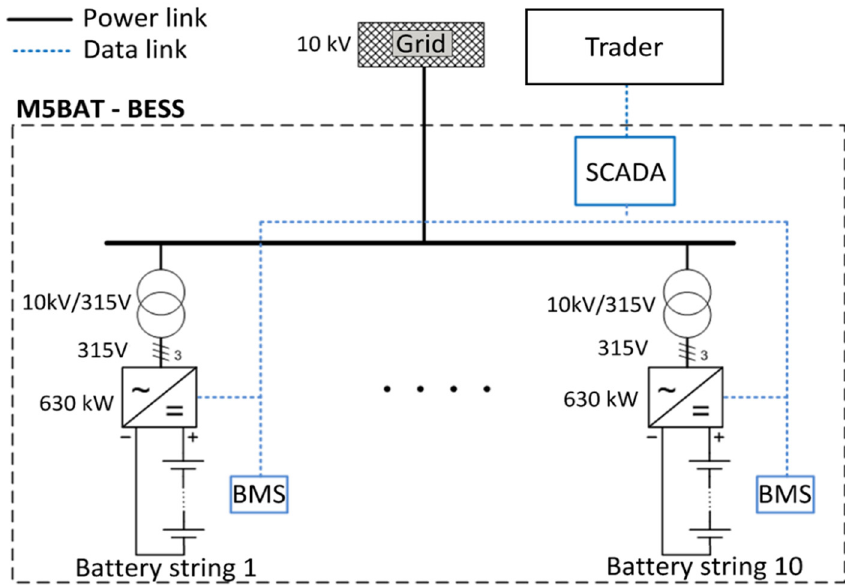
Figure 2. M5BAT structure and connection diagram (own design according to [23]).